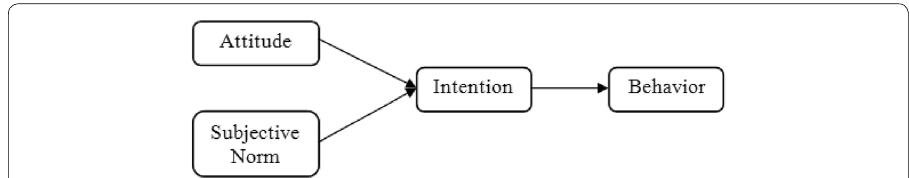
Fig. 1 Theory of reasoned action (TRA) (Ajzen and Fishbein